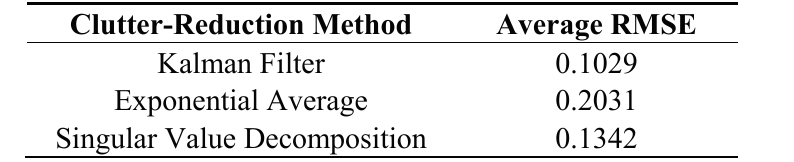
Table 3. Performance comparison of different clutter-reduction